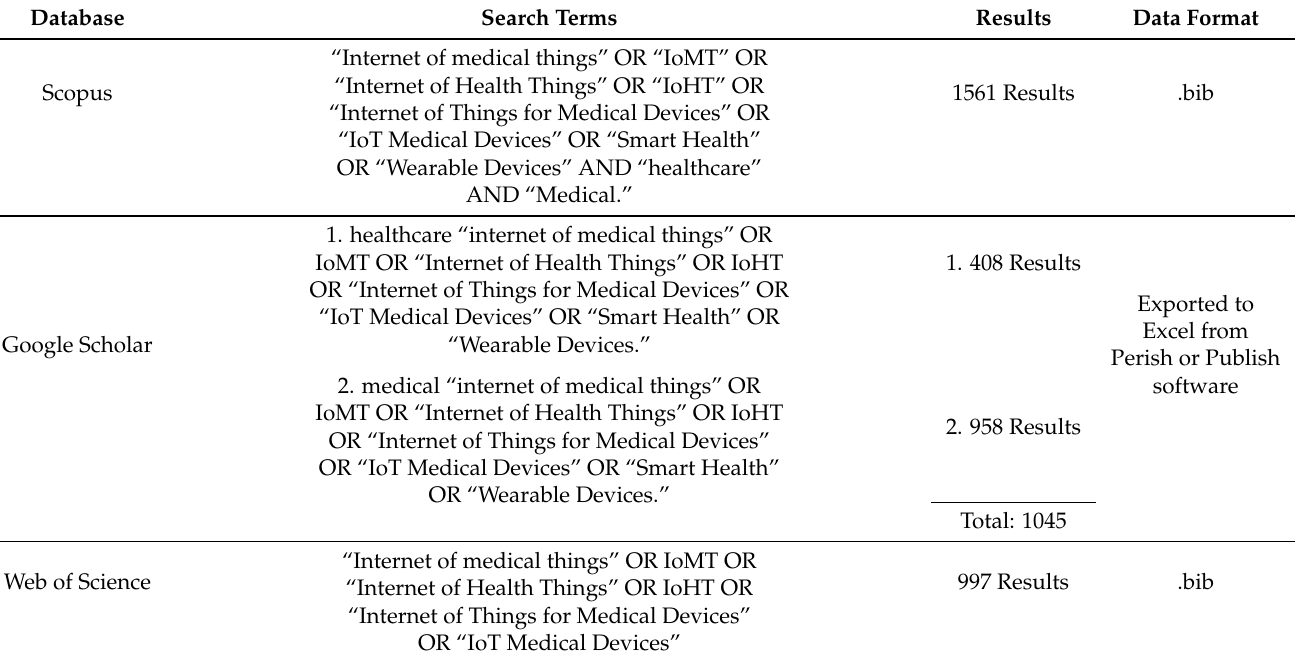
Table 1. Databases searched along with the search strings, retrieved results, and data format for each database. The GS string is divided into two strings because the Publish or Perish software does not allow downloading more than 100